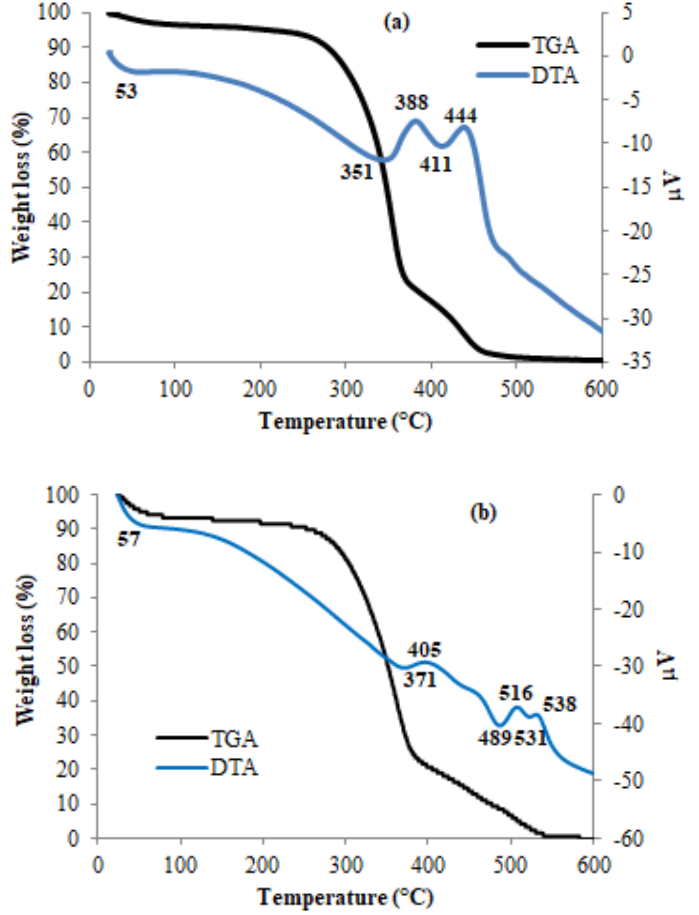
Figure 4. TGA/DTA curves of untreated Populus tremula fibers ( a ) and extracted cellulose ( b ) (Air flow, and heating rate of 10° min −1 ).